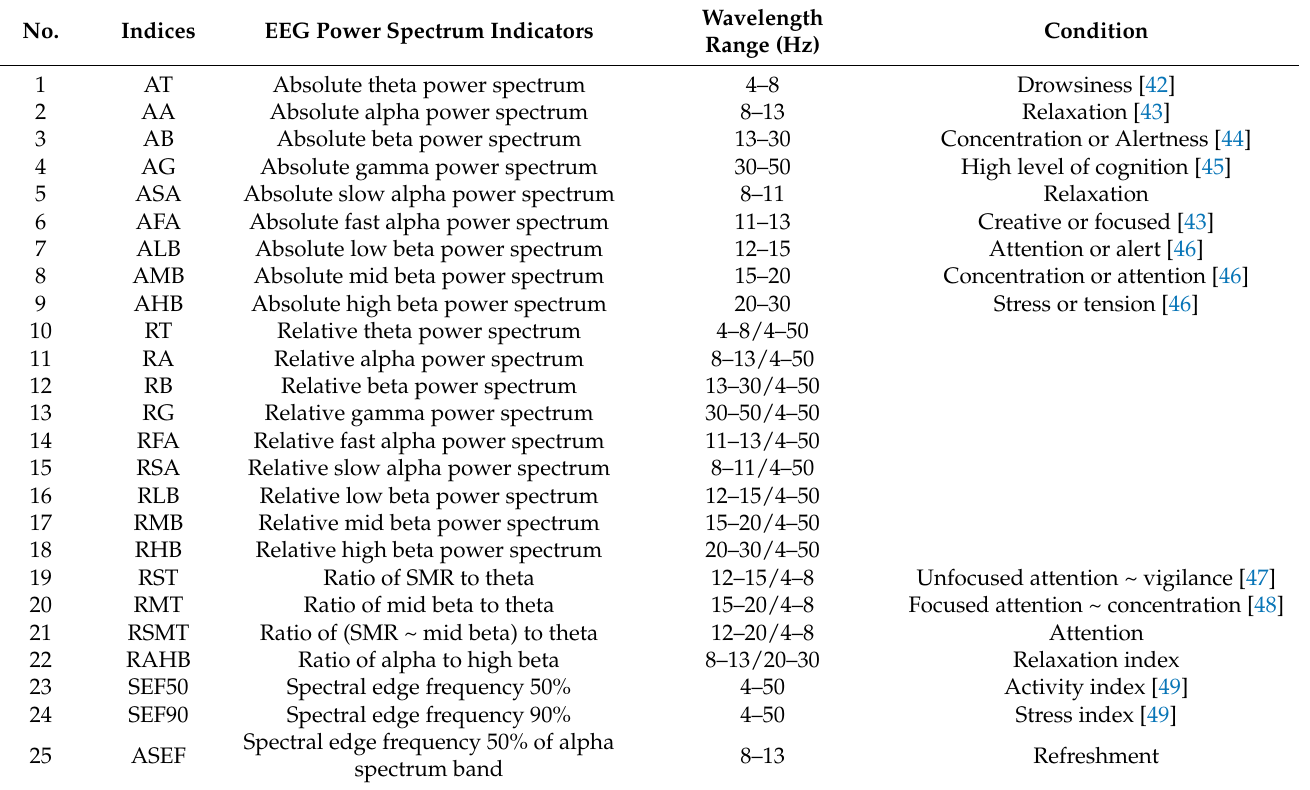
Table 1. The abbreviations, full names, and wavelength ranges of the EEG power spectrum